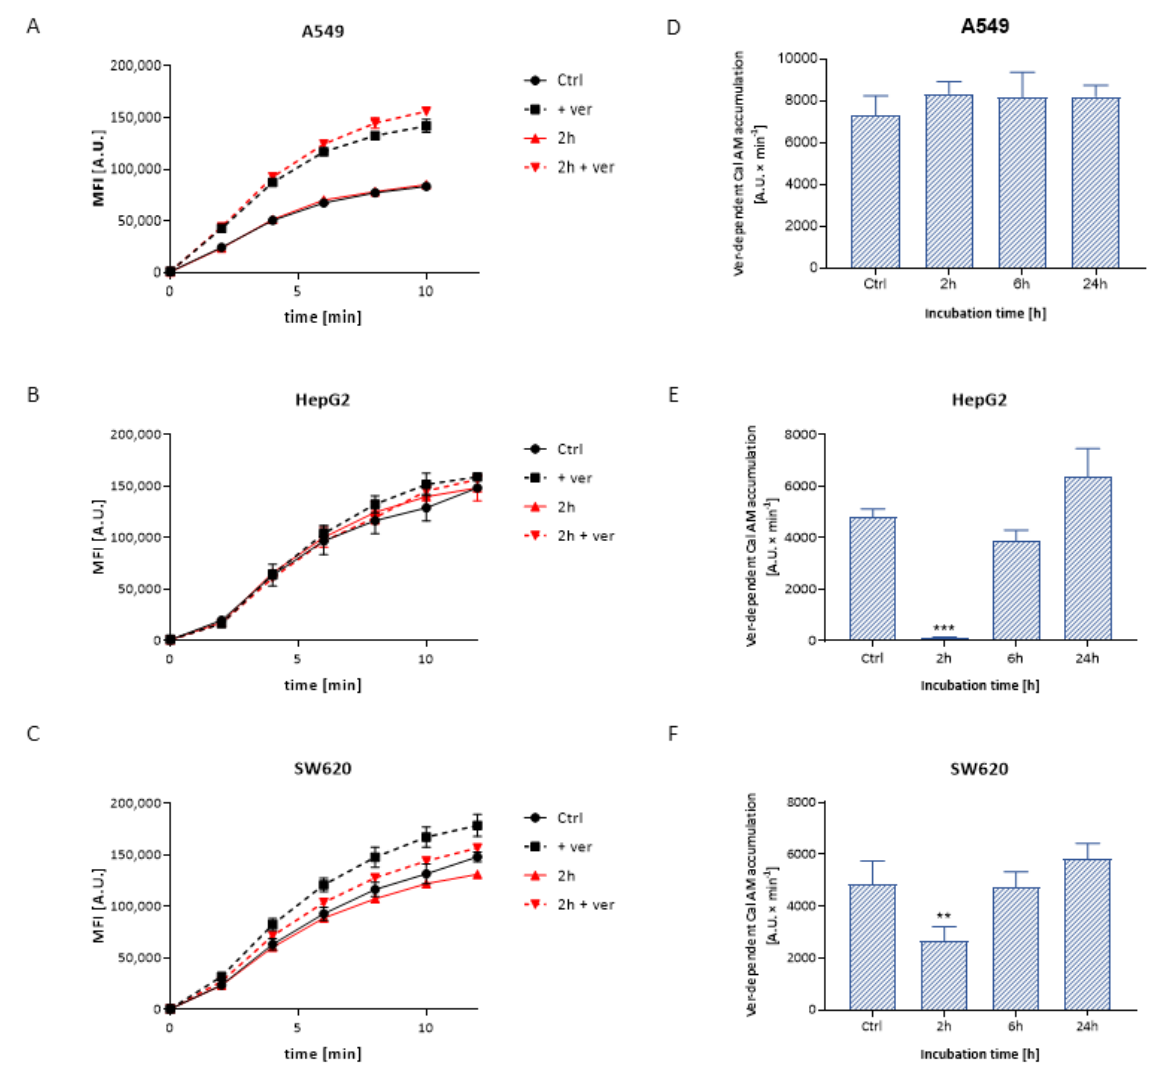
Figure 3. Illustrative plot of intracellular Cal AM accumulation versus time in A549 ( A ), HepG2 ( B ) and SW620 ( C ) cells treated with Ag20 in the presence and absence of verapamil. Verapamil-dependent calcein AM accumulation in A549 ( D ), HepG2 ( E ) and SW620 ( F ) cells treated for 2, 6 and 24 h with 50 µ g/cm 3 Ag20 expressed as the slope of the rectilinear segment of the fluorescence increment over time. One-way ANOVA and Dunnett’s post hoc test were used. Significance level: ** p < 0.01; *** p < 0.001. Data expressed as arithmetic mean ± SD; n = 3.